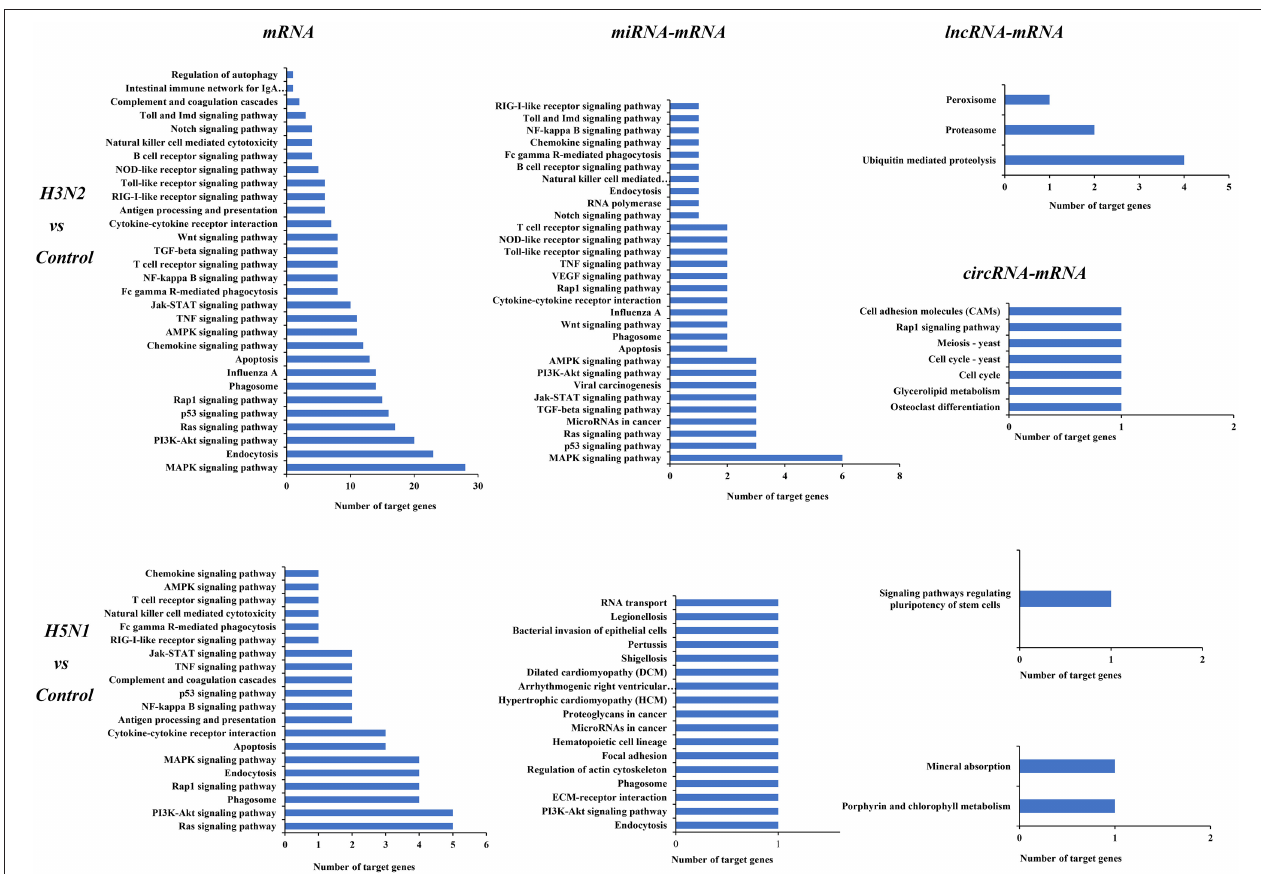
FIGURE 5 | KEGG pathways of differentially expressed mRNAs and target genes of differentially expressed miRNAs, lncRNAs, and circRNAs. The horizontal axis shows the number of genes, and the vertical axis shows each